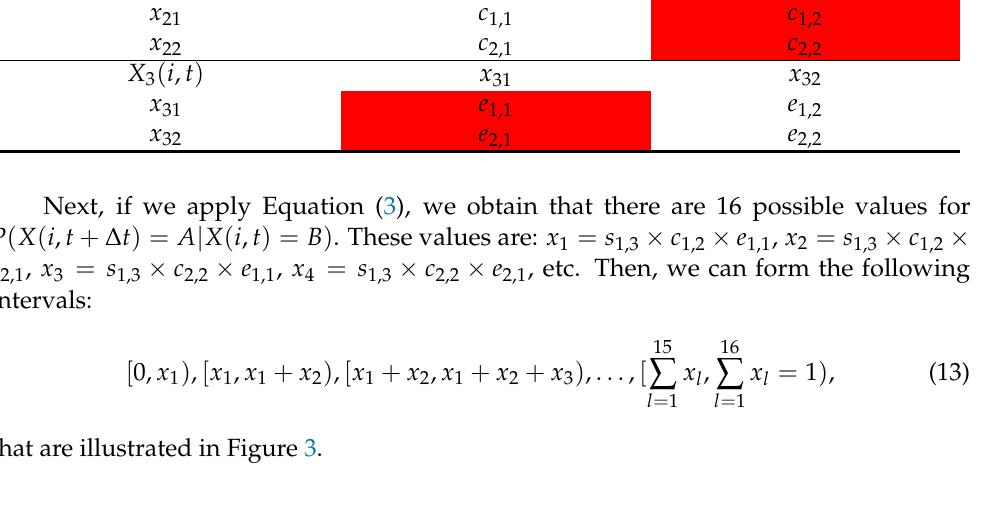
Table 6. CPDs of the target (on the left) and efficient countermeasures (on the right). X 2 ( i , t